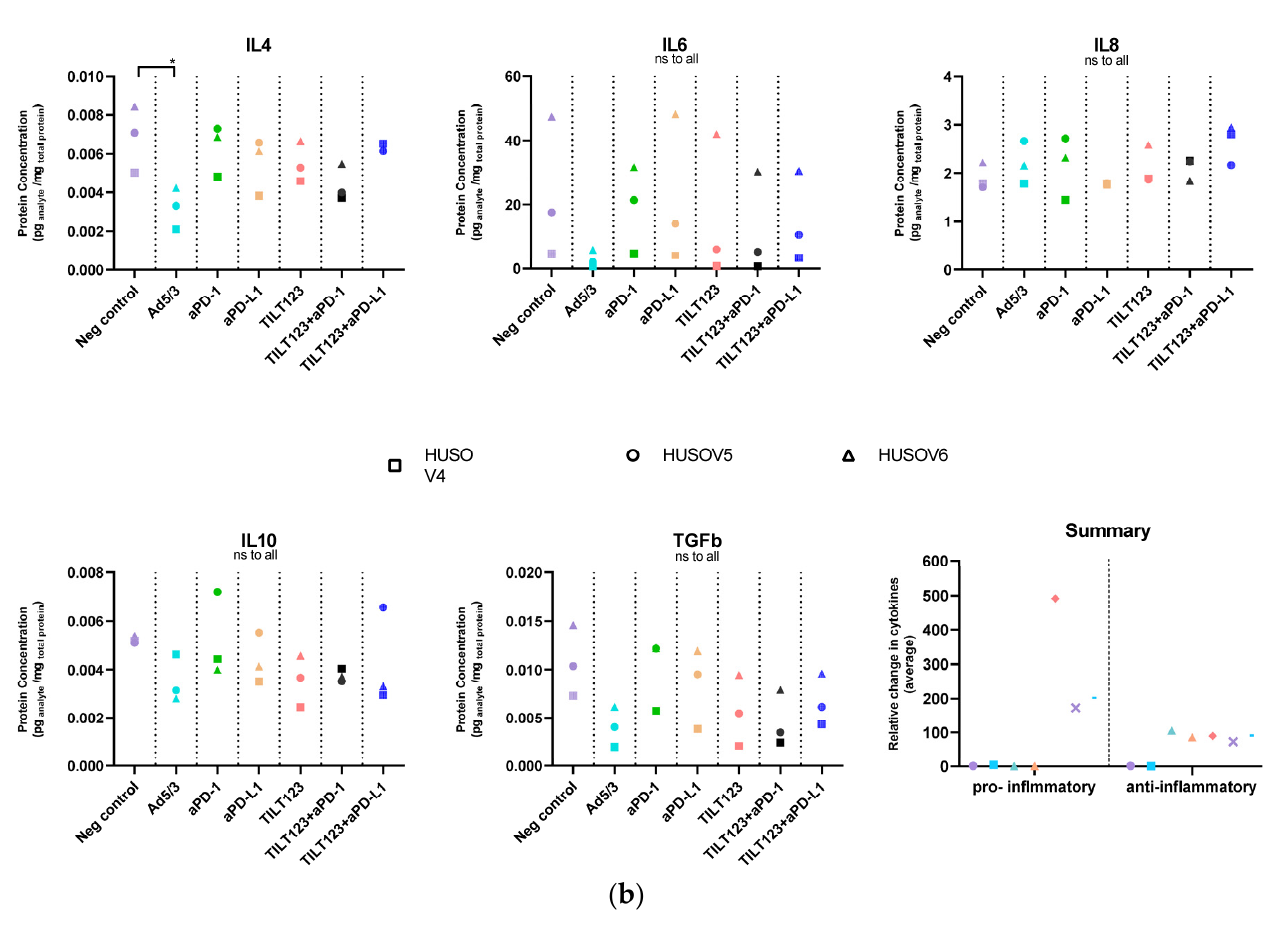
Figure 2. Cytokine concentration changes in response to virotherapy and or ICI treatments. Three patient tumor samples (HUSOV4- HUSOV6) were treated with backbone virus, TILT-123, anti-PD-1, anti PDL-1, or a combination of TILT-123 and checkpoint inhibitor. (Viruses 100 VP/mL, ICI 20 mg/mL). Fresh media functioned as a control condition. The cytokine concentrations were measured from the supernatants on day 7 by flow cytometric assay. ( a ) Pro-inflammatory cytokines ( b ) Anti-inflammatory cytokines and summary of A &B combined. Statistics; One way ANOVA (Tukey’s multiple comparison) was used for statistics, with * p ≤ 0.05, ** p ≤ 0.01, *** p ≤ 0.001, data have been gathered from